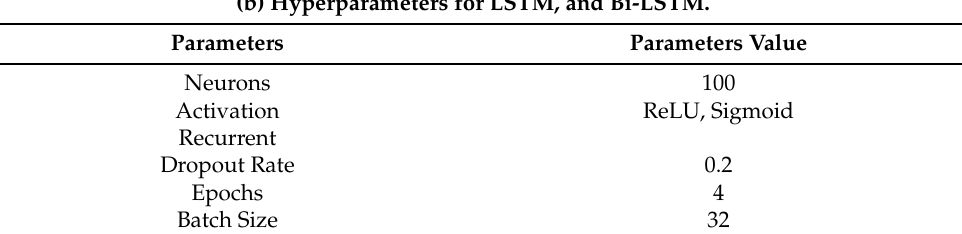
(b) Hyperparameters for LSTM, and Bi-LSTM.